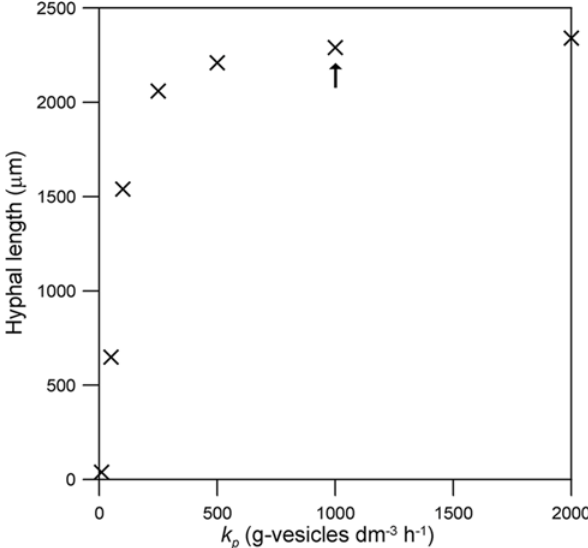
initial values of the variables and the other parameter values are as listed for Rhizopus oligosporus in Table 1.